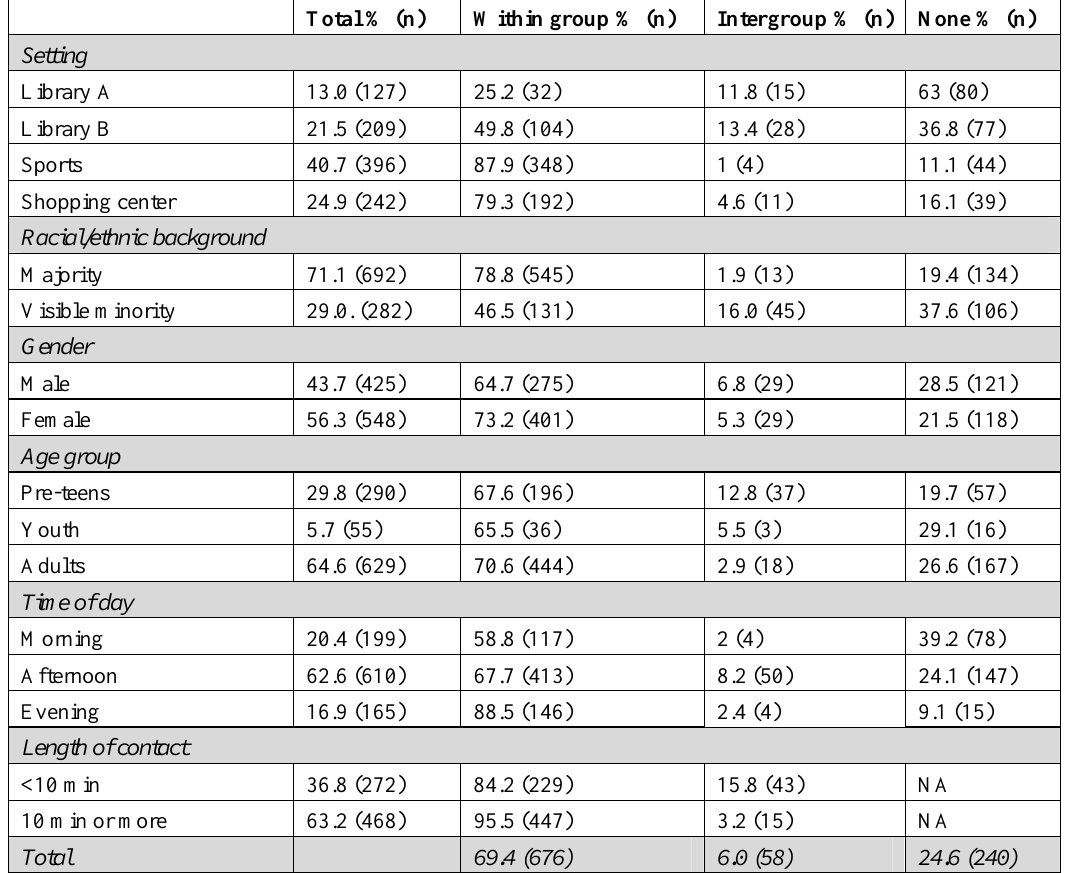
Table 1. Sample characteristics by type of